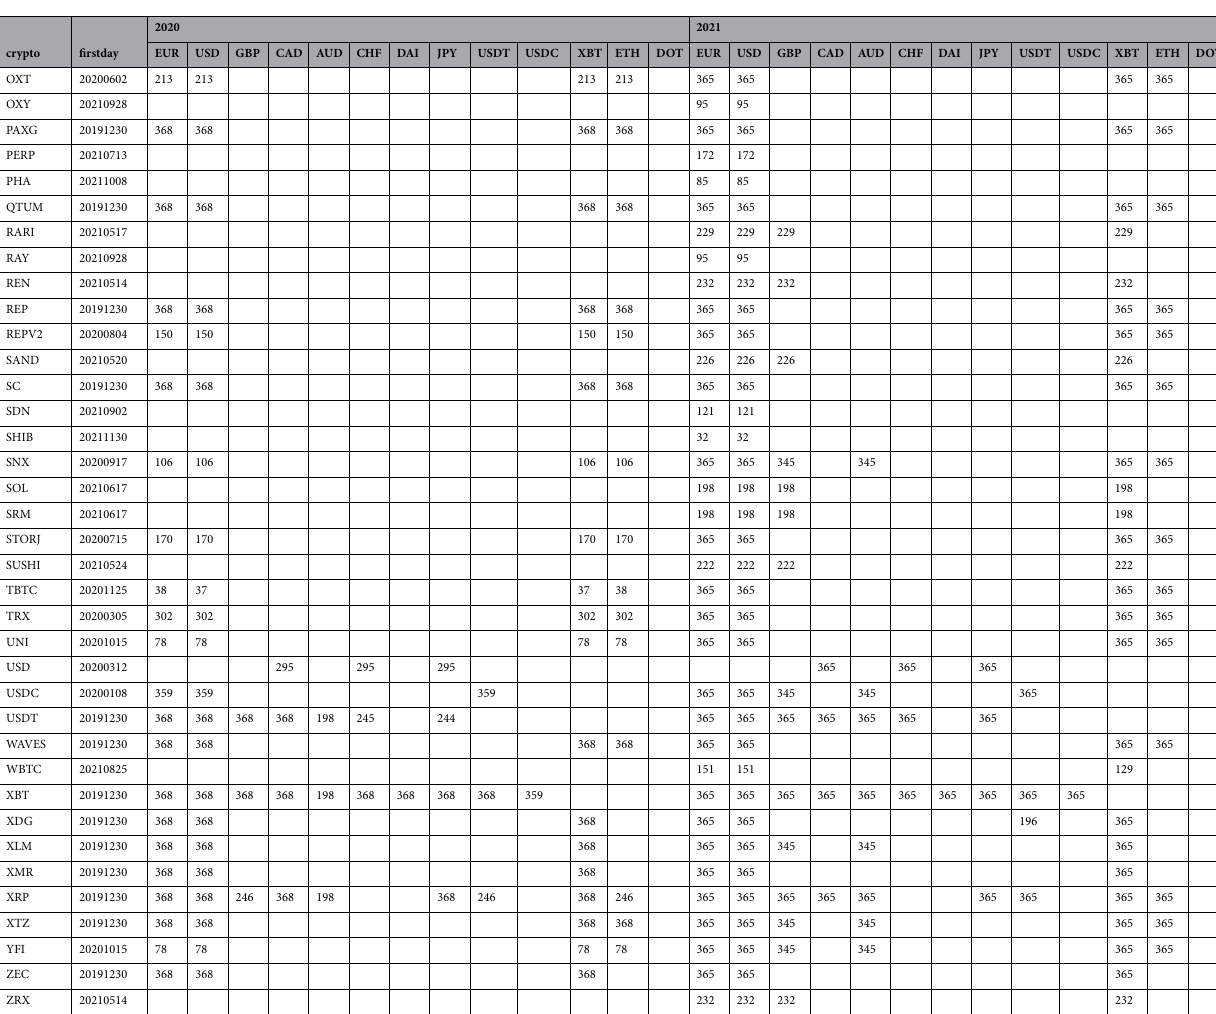
Table 4. Data coverage on 2020 (starting on Monday 30/12/2019) and 2021. Rows are cryptocoins, columns correspond to fiat coin used to trade. The crypto column reports the Ticker used to list the cryptocoin on the Kraken Exchange. Firstday column show when the cryptopair appear for the first time (on the 2020 or 2021) using the format yyymmdd. For each fiat, are shown the number of days available for the crypto-fiat pair in 2020 and in